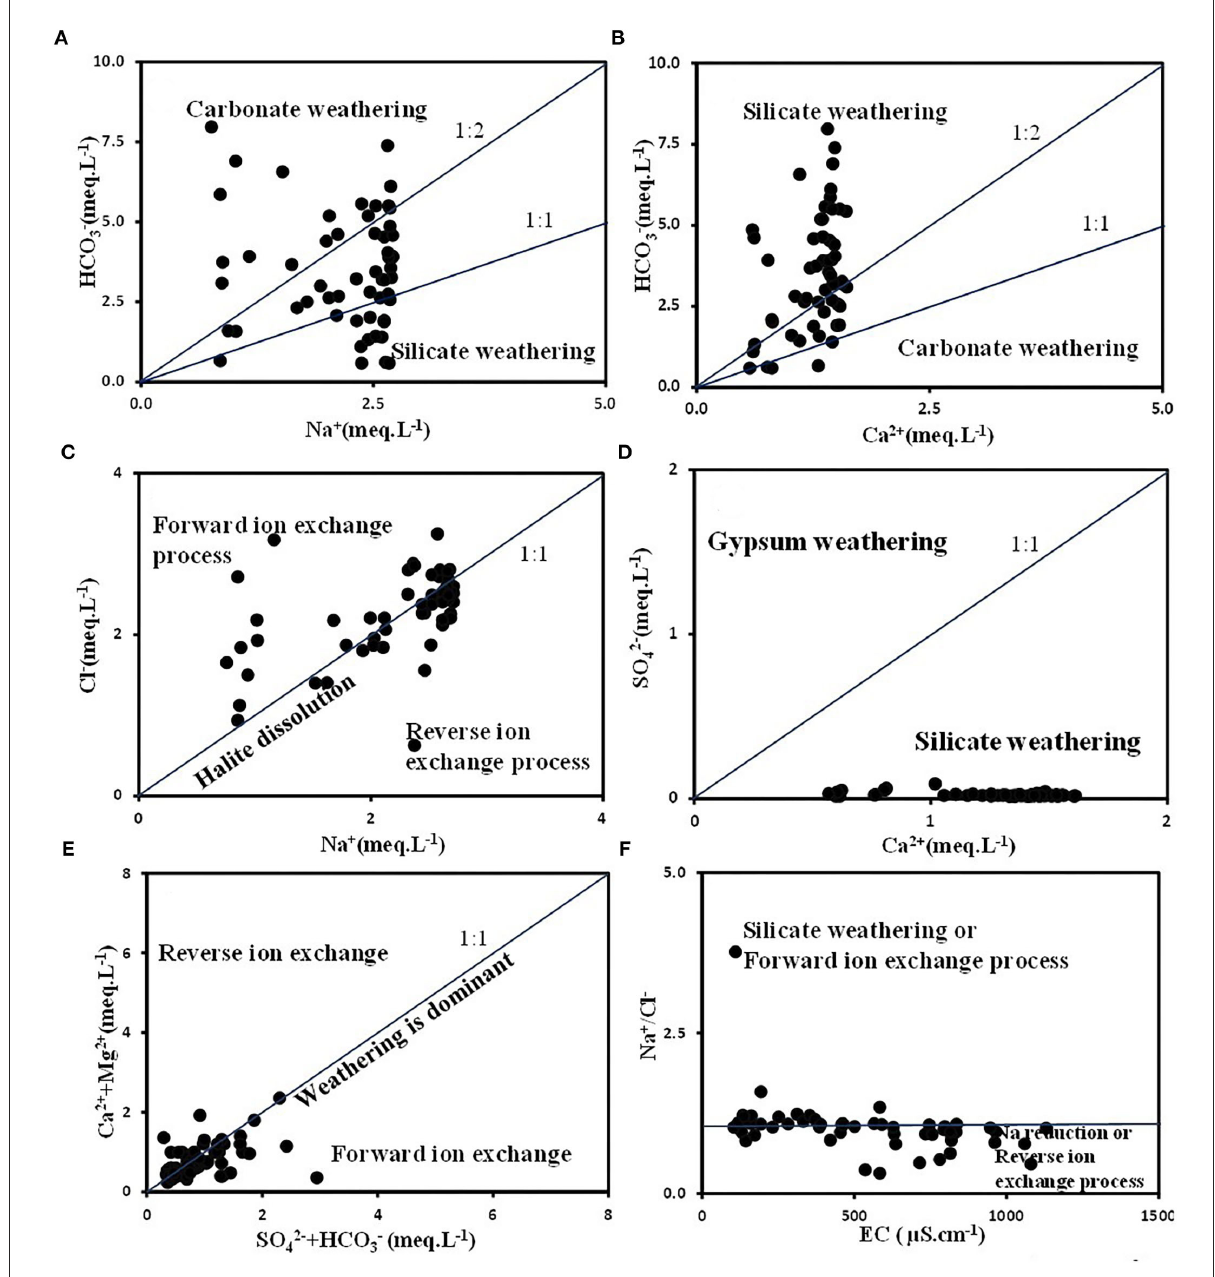
FIGURE5 Scatter plots used for source-deduction (A) HCO − 3 vs. Na + (B) Ca 2 + vs. HCO − 3 (C) Na + vs. Cl − (D) Ca 2 + vs. SO 2 − 4 (E) Ca 2 ++ Mg 2 + vs. HCO − 3 and (F) EC vs. Na + /Cl − .